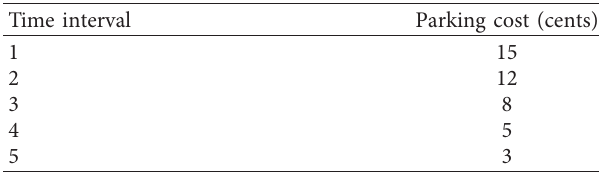
Table 12: Parking cost for each time